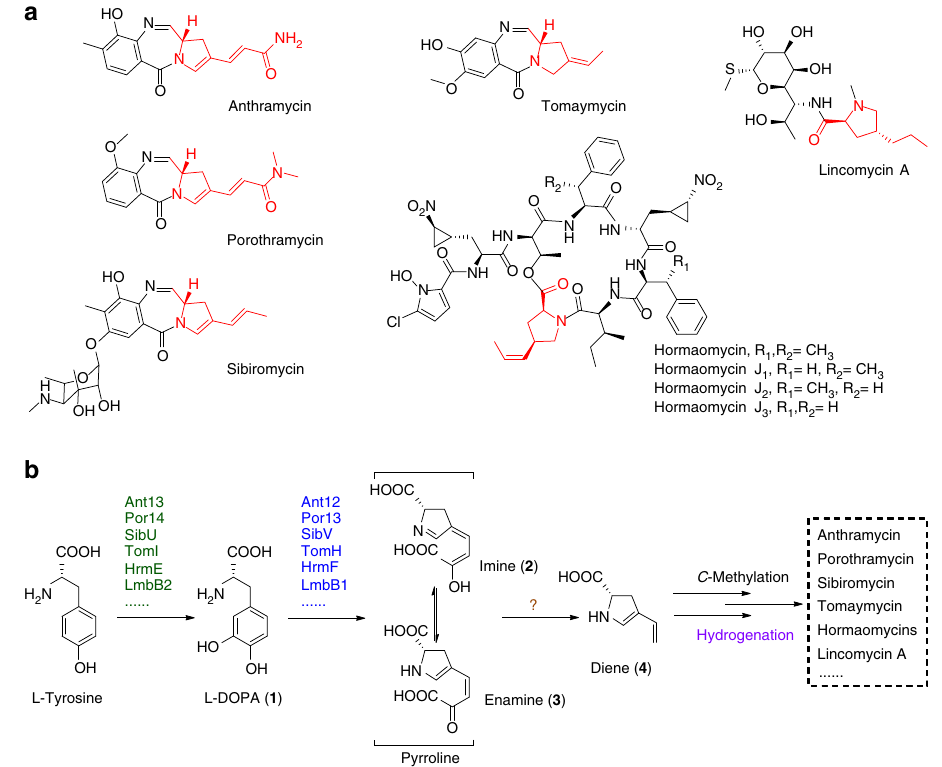
Figure 1 | Chemical structures and biosynthetic pathway. ( a ) Representative ALDP (highlighted in red)-containing natural products. ( b ) Common biosynthetic steps (differentiated in colour) during the formation of various ALDP